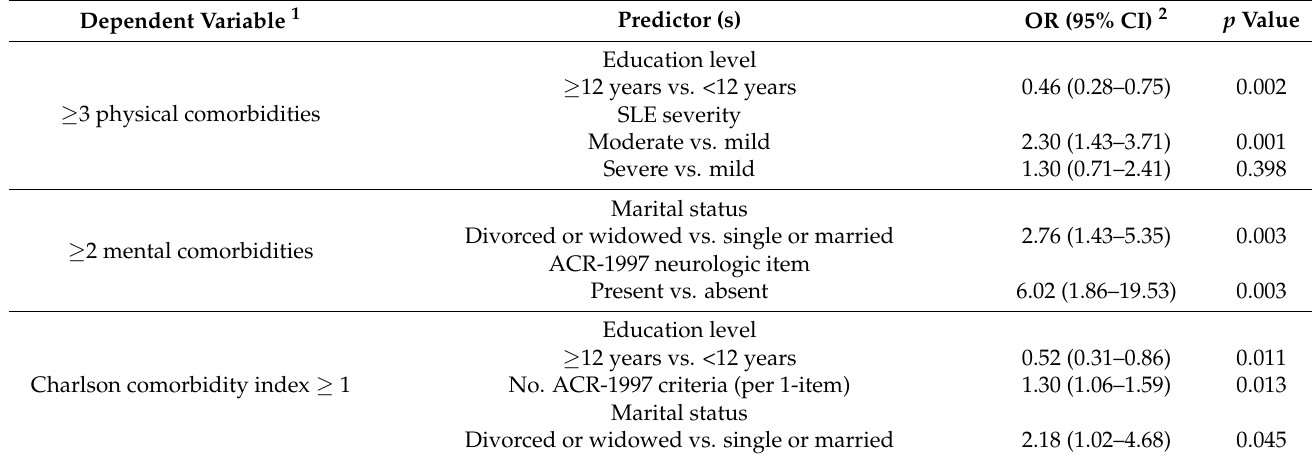
Table 4. Predictors for the presence of comorbidities in patients with